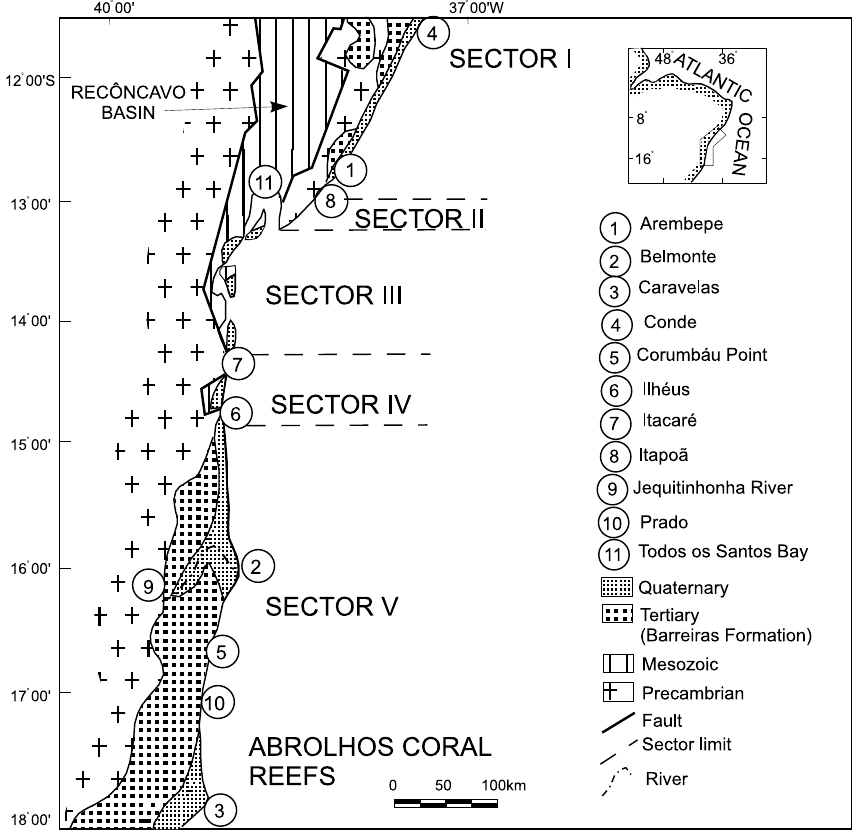
Fig. 2 – Simplified geological map of the study area showing the location of the different physiographic sectors discussed in the